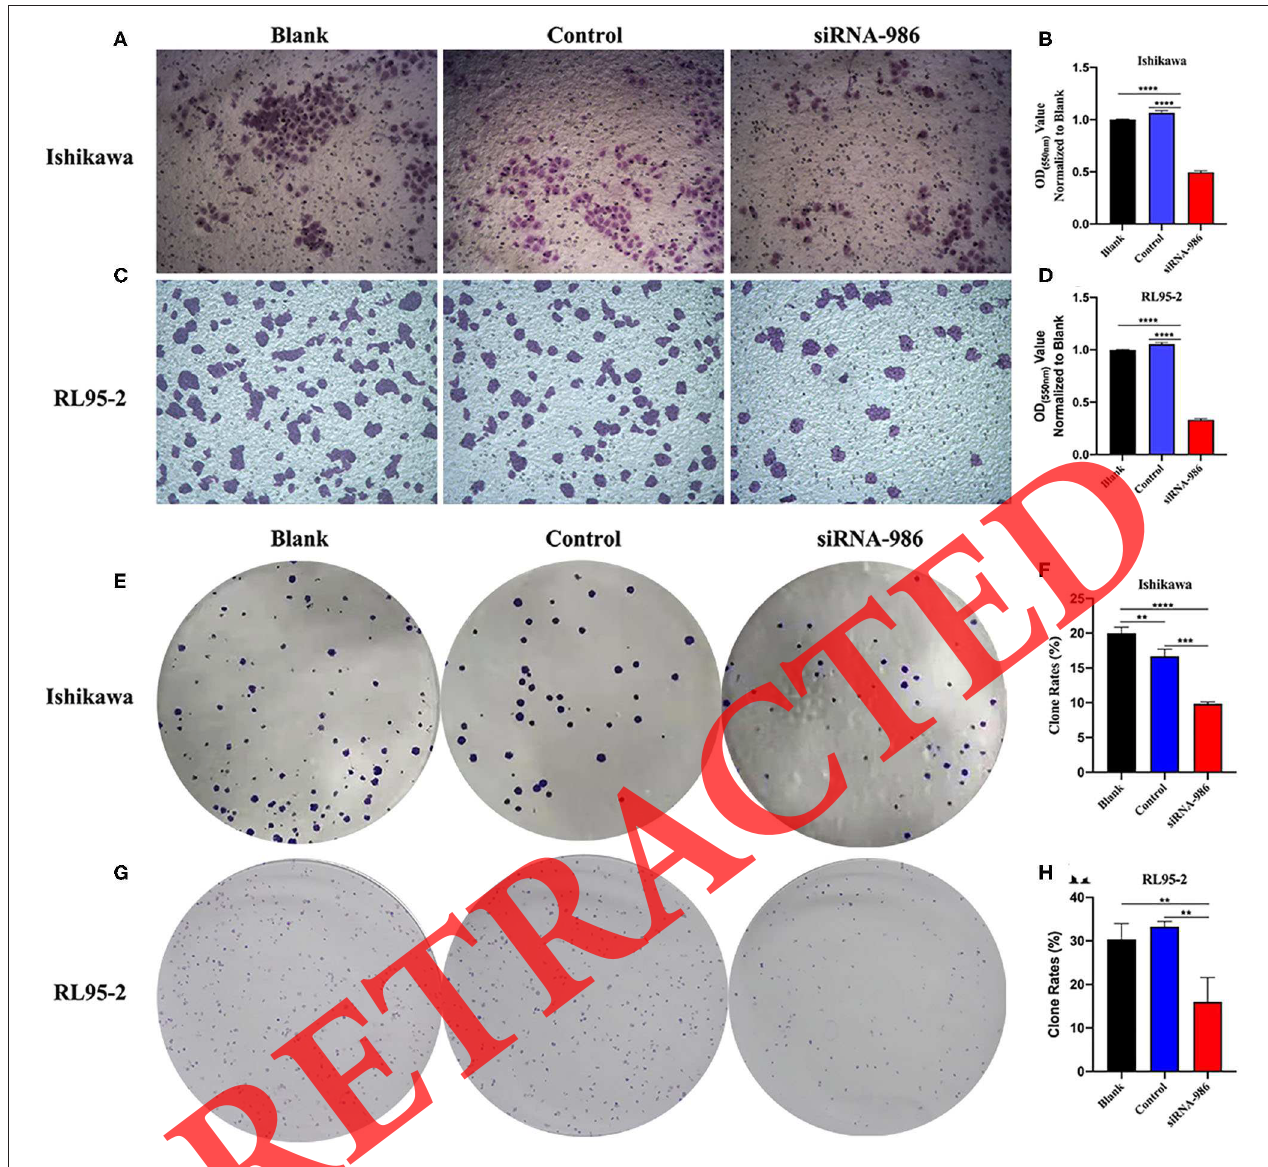
FIGURE 4 | Inhibition of CCT7 Suppressed the Capacity of Tumor Cells Migration and Colony Formation. Migration (A–D) and colony formation (E–H) of Ishikawa and RL95-2 cells treated with CCT7 siRNA-986 were examined. ** p < 0.01, *** p < 0.001, **** p < 0.0001, all values represent Mean ±